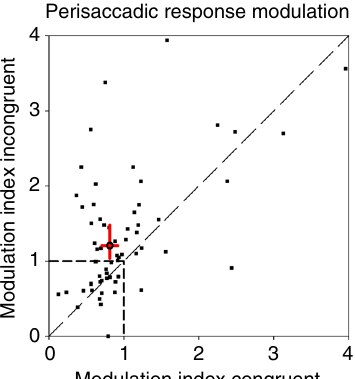
Fig. 6 Modulation index for congruent and incongruent stimulation. Each data point represents data from a single neuron, with the x -value depicting the index in the congruent condition and the y -value depicting the index of the same neuron in the incongruent condition. The majority of data points lies above the diagonal. For the population of cells, the median of the index was signi fi cantly < 1.0 (0.812, one-sided sign test, P < 0.05) in the congruent condition, and signi fi cantly > 1.0 in the incongruent condition (1.206, one-sided sign test, P < 0.05). The 95% con fi dence intervals (red lines) as determined from bootstrapping were < 1.0 in the congruent condition and > 1.0 in the incongruent condition